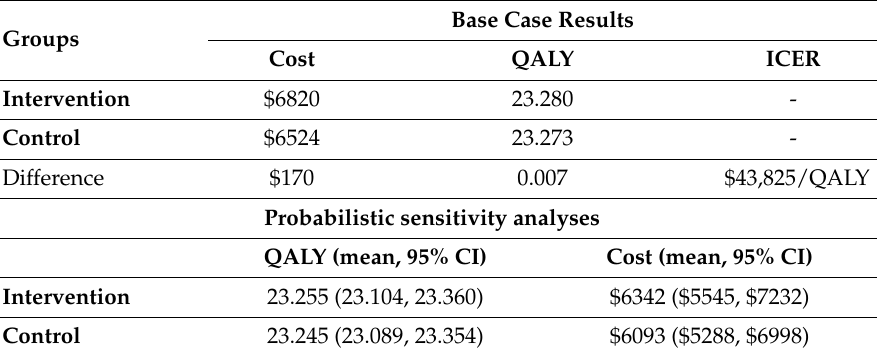
Table 2. Results of cost-effectiveness